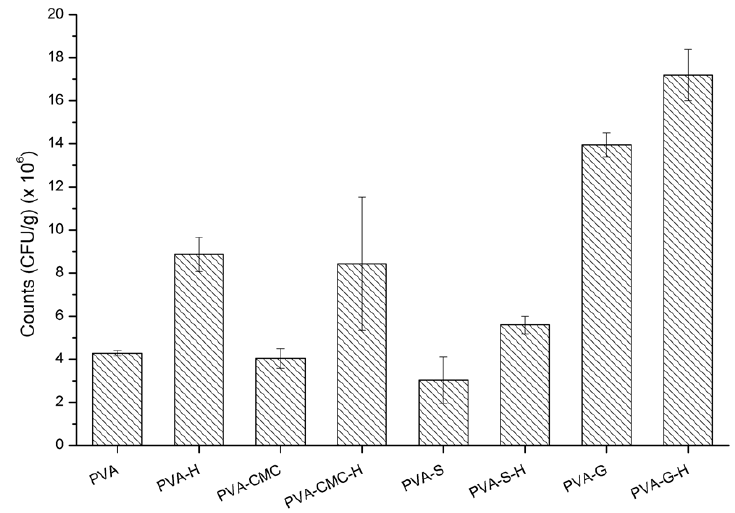
Figure 7. Antimicrobial analysis regarding the samples’ activity.